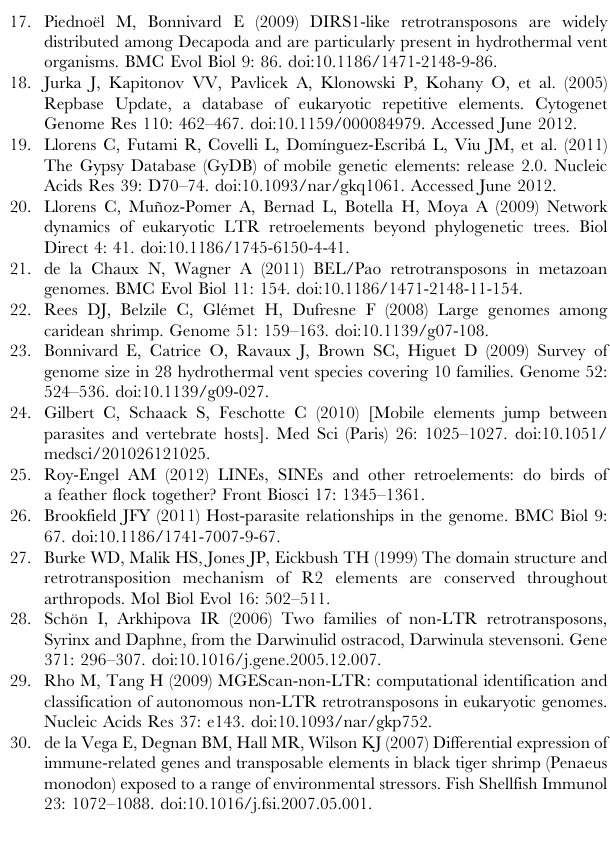
Figure S1 Characterization strategy of full-length LTR- retrotransposons. A copia retrotransposon is used as example. For each of the five steps, the known part of the element is represented by a full line whereas the walking part is indicated by colored dotted arrow: red, PCR or TE Walking; green, PBS Walking; purple: PCR using specific primers. The conserved domains used to design the degenerate primers and the PBS sequences are represented by blue and green triangles, re- spectively. Figure S2 Phylogenetic relationships among GalEa-like retrotransposons inferred from Neighbor-Joining anal- ysis of RT/RH amino acid sequences. Statistical support ( . 50%) comes from non parametric bootstrapping using 100 replicates. Two to three representative elements of the other Copia clades are also included to the phylogeny. Gypsy sequences were used as outgroup. Table S1 Report of the sequences obtained from PCR approaches. For each element, the host species, name, length and accession number are given, as well as the PCR methodology and primers used. Table S2 List of GalEa-like retrotransposons identified. For each element, the corresponding host species and the